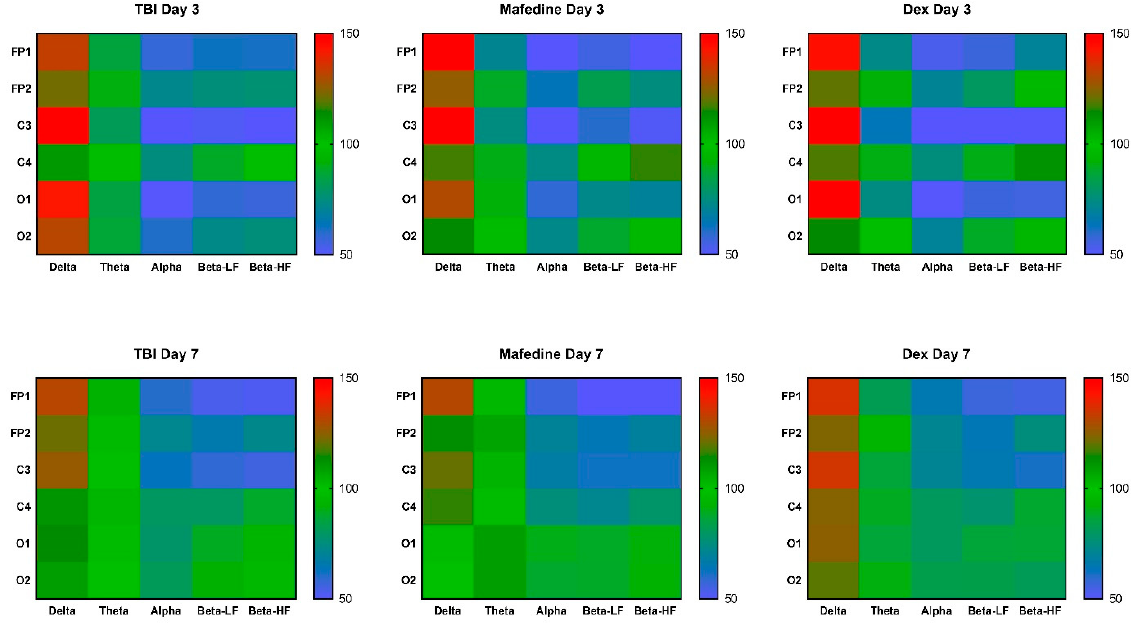
Figure 3. A heatmap of δ -, θ -, α -, LF and HF β -rhythm index values in channels FP1, FP2, C3, C4, O1, and O2 at post-TBI days 3 and 7. Data were normalized to the respective healthy control values.